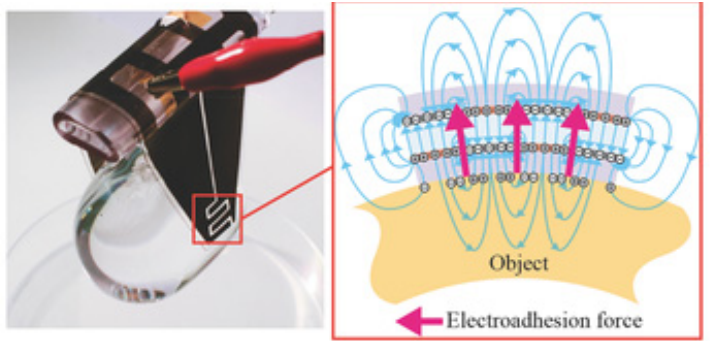
Figure 2. Electroactive polymers (EAP) [64] (Copyright 2015, John Wiley & Sons).